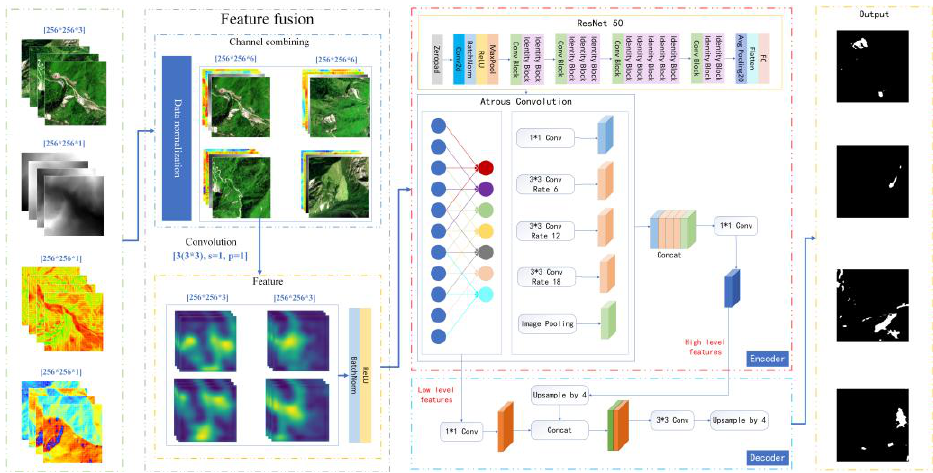
Figure 3. Overall architecture of embedded multichannel spectral–topographic feature fusion model based on DeepLab V3+.